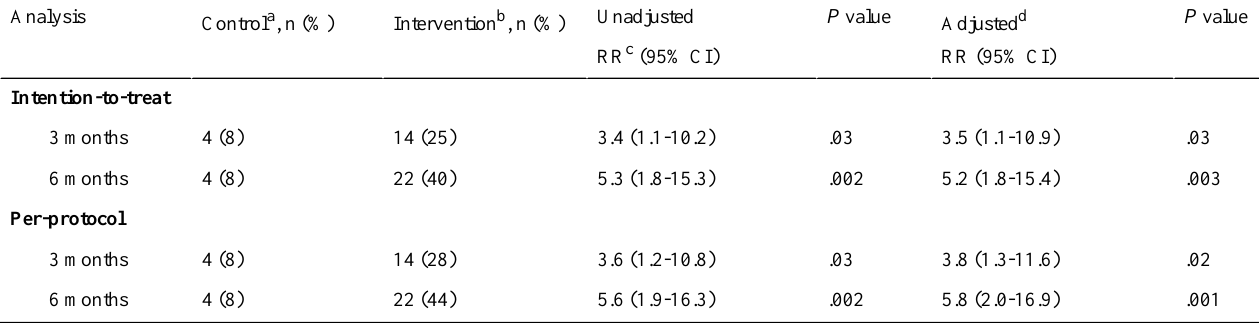
Table 2. Proportion of patients with ≥ 5% weight loss in the control and intervention